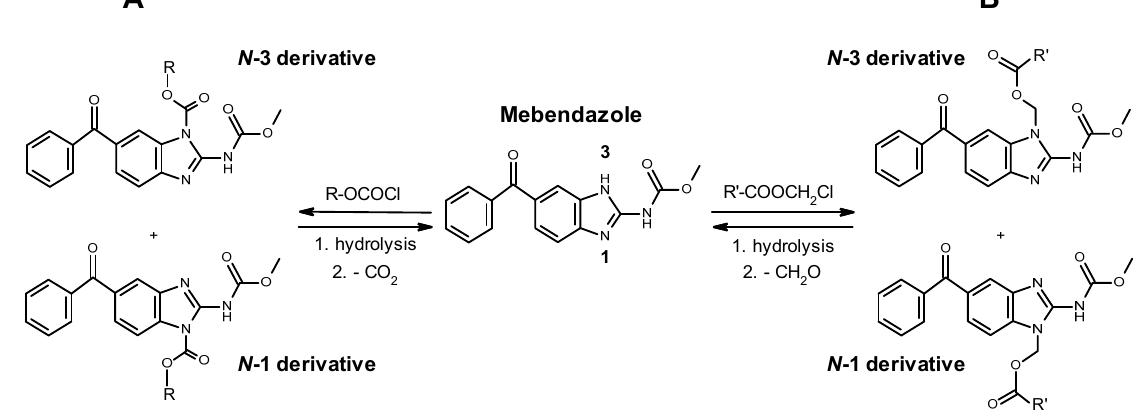
Figure 2. Generation and cleavage of carbamate ( A ) and acyloxymethyl ( B ) derivatives of mebendazole (MBZ). Due to a tautomerism of the MBZ molecule (1,3-H shift), a statistical mixture of N -1 and N -3 derivatives is formed in all cases. The presence of both isomers was indicated by doubled high-performance liquid chromatography (HPLC) peaks and nuclear magnetic resonance (NMR) signals of carbamate protons. For better clarity, only N -3 isomers will be depicted in the next figures.